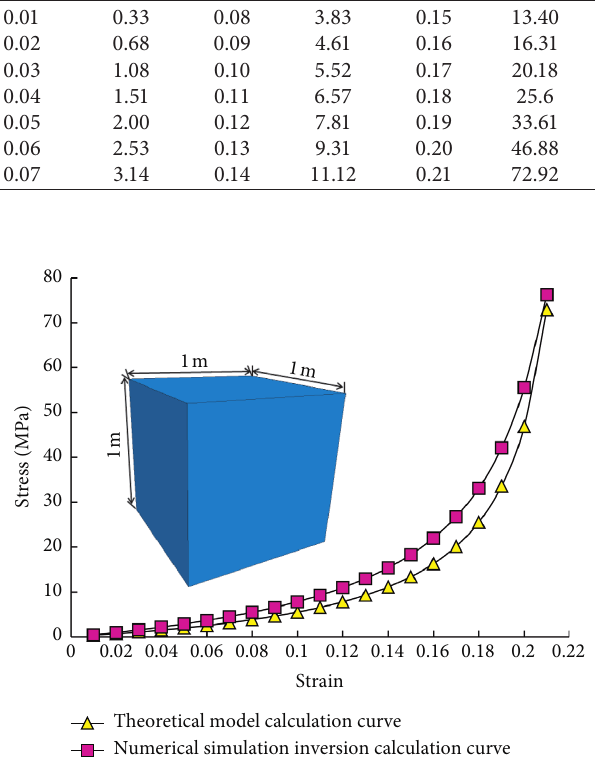
Figure 4: Numerical simulation inversion and theoretical calcu- lation of stress-strain relationship in the collapse